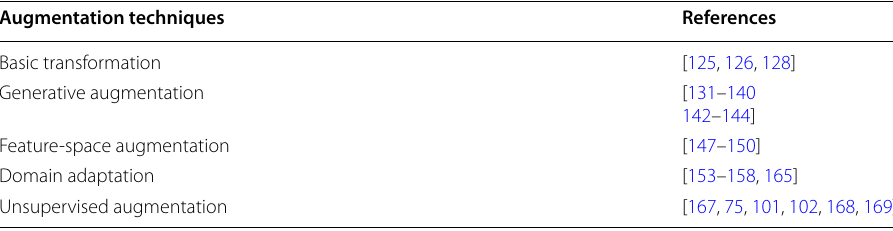
Table 2 Summary of augmentation methods Augmentation